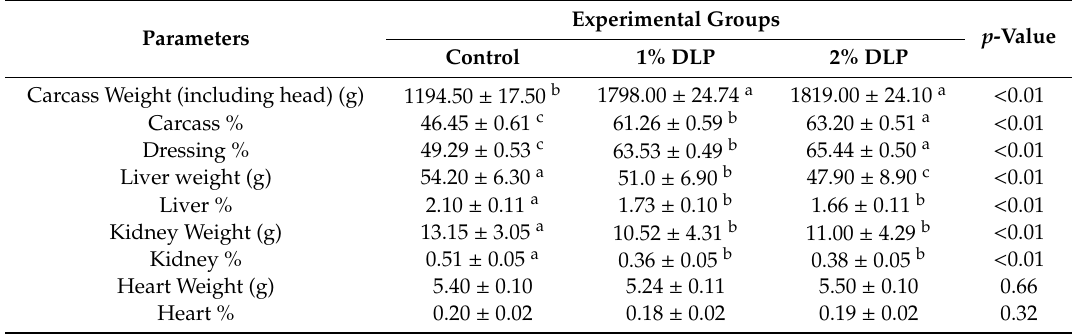
Table 4. Carcass traits of growing rabbits after dietary dried lemon supplementation.